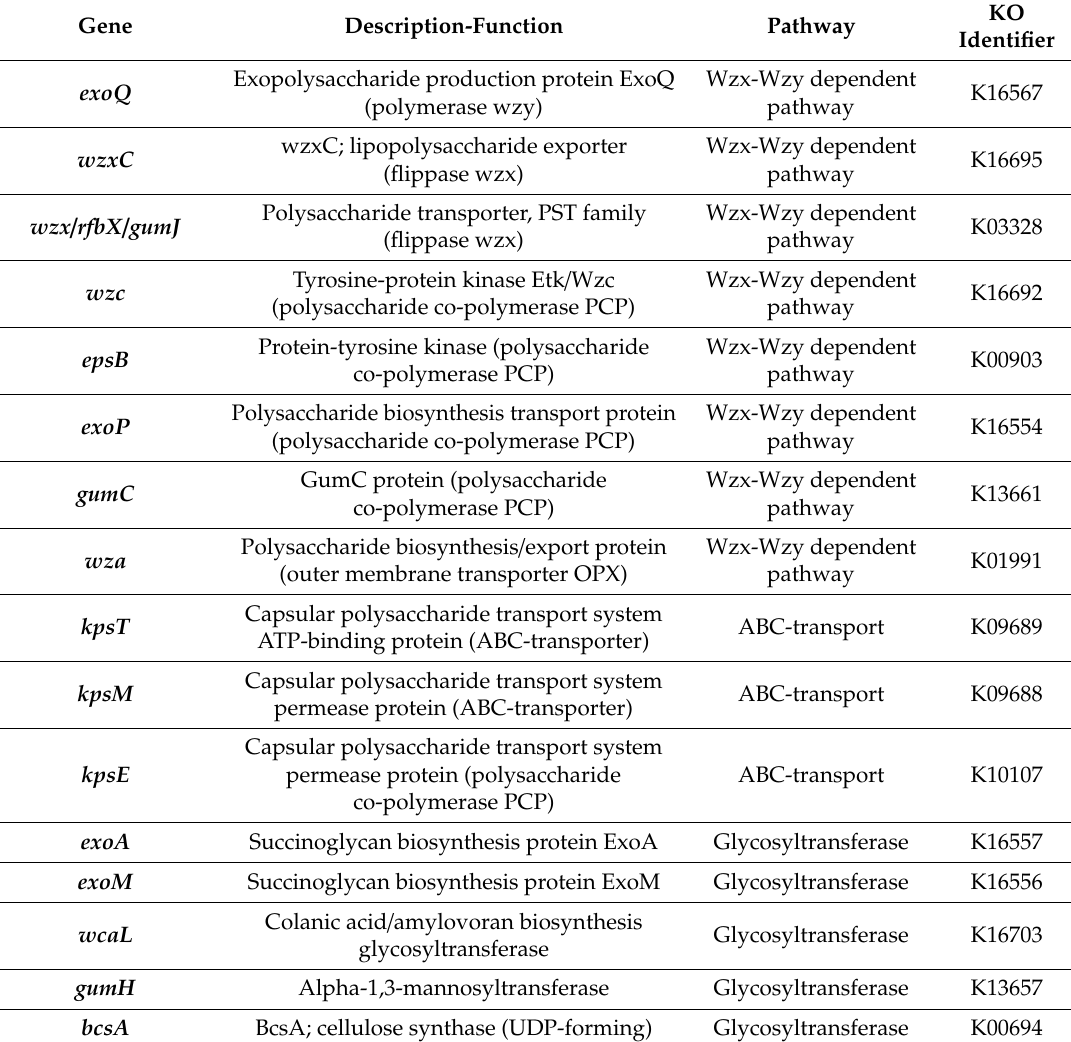
Table 4. Description of marker genes involved in the synthesis, assembly, and transport of extracellular and capsular polysaccharide substances [20,58,84] that are displayed in Figure 4. All genes used as a proxy for extracellular metal sequestration are included in Table